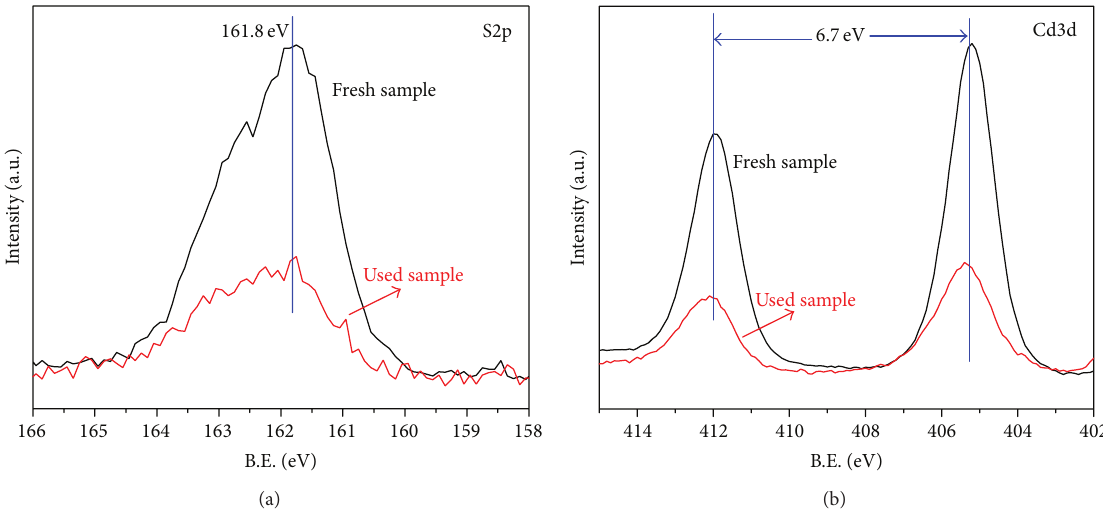
Figure 7: S2p and Cd3d XPS spectra of CdS/CN-10 electrode before and after used in cycling photocatalytic experiments.